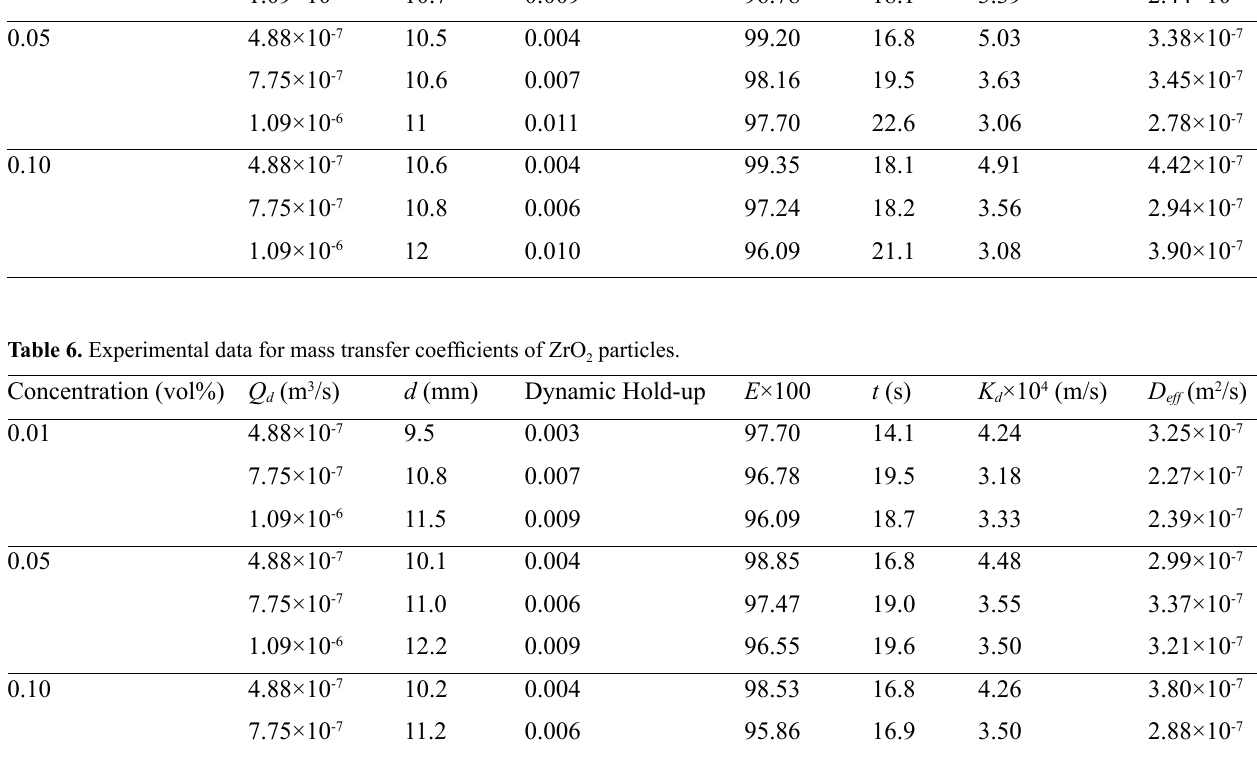
Table 5. Experimental data for mass transfer coefficients of TiO